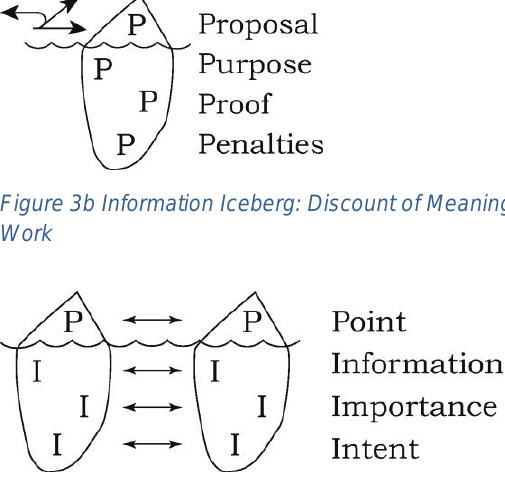
Figure 3c Information Iceberg: Discount of Meaning -